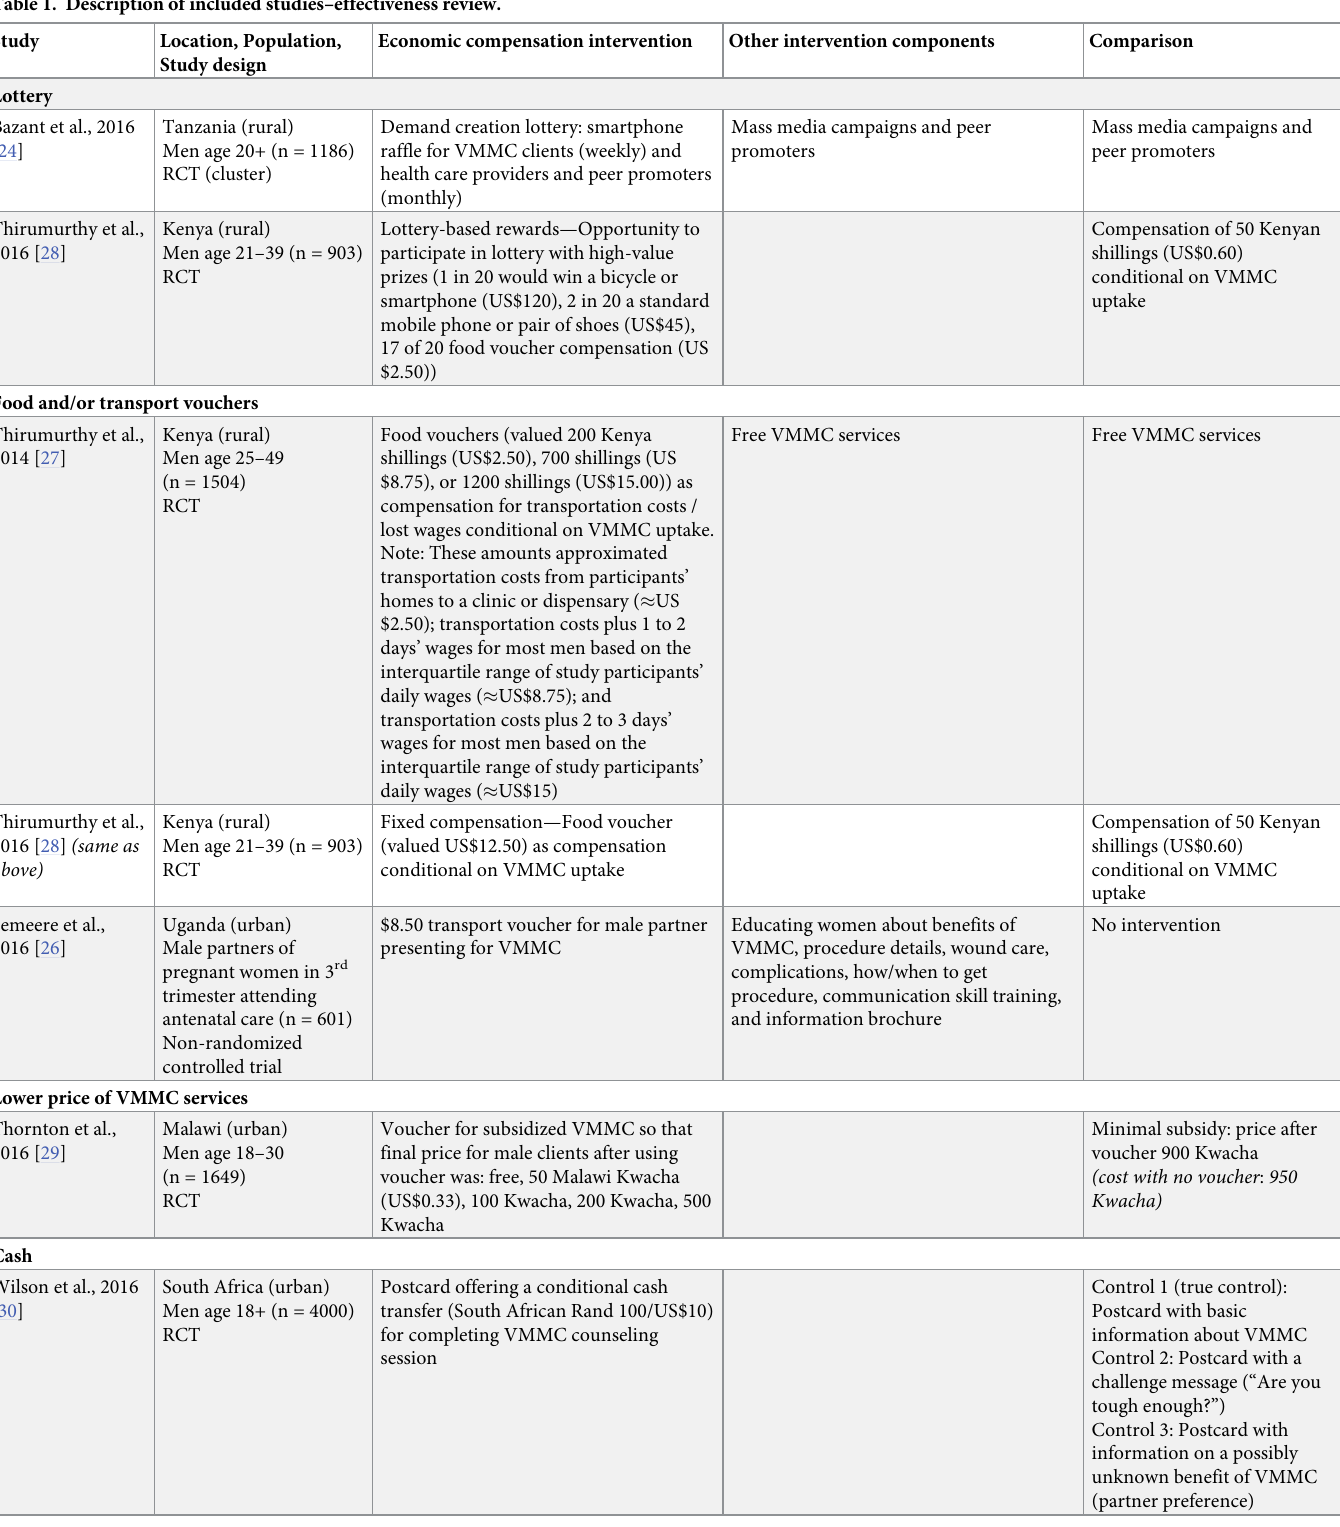
Table 1. Description of included studies–effectiveness